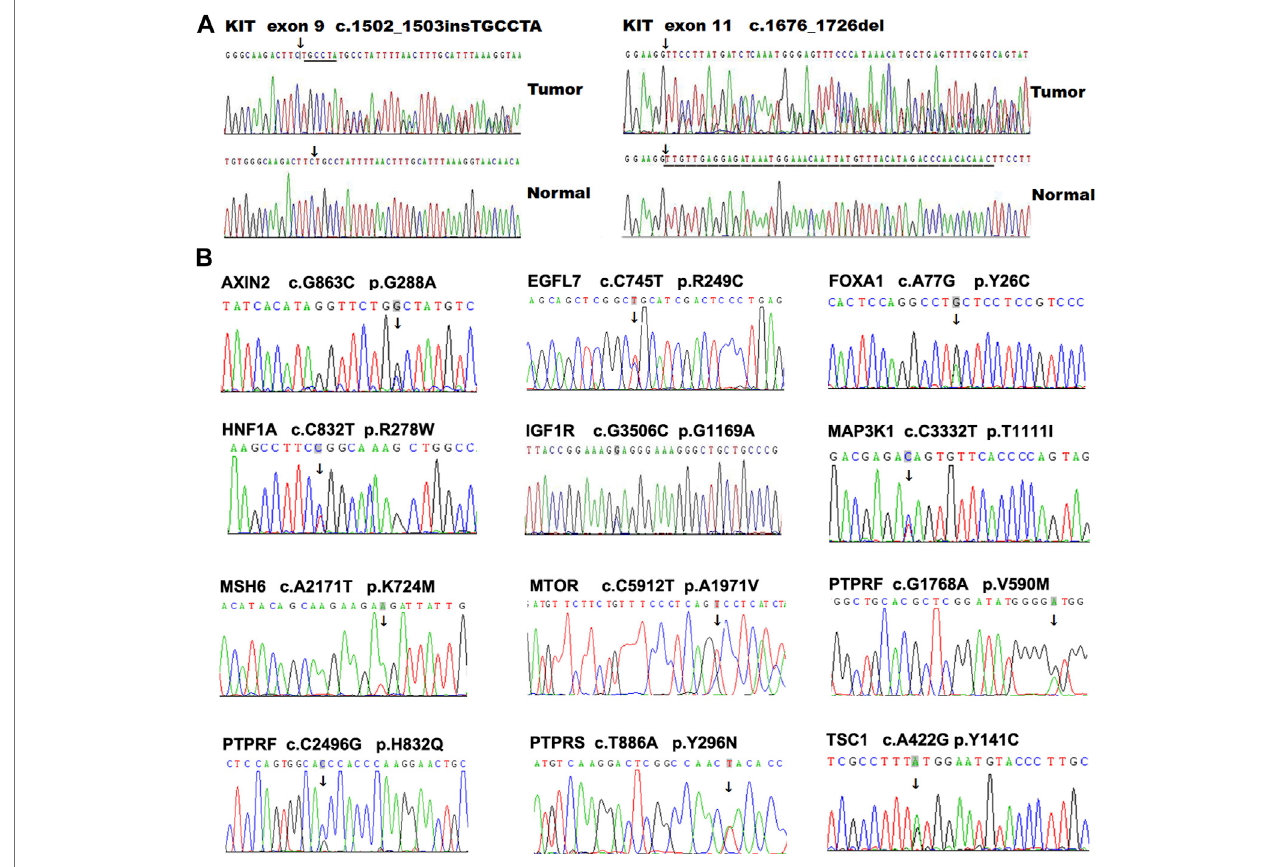
FIGURE3 | Mutation validation in GIST tumorsusing PCR-based Sanger DNA sequencing. Somerepresentative variations located in KIT. (A) and other genes (B) were validated using PCR-based Sanger DNA sequencing in GIST tumors.